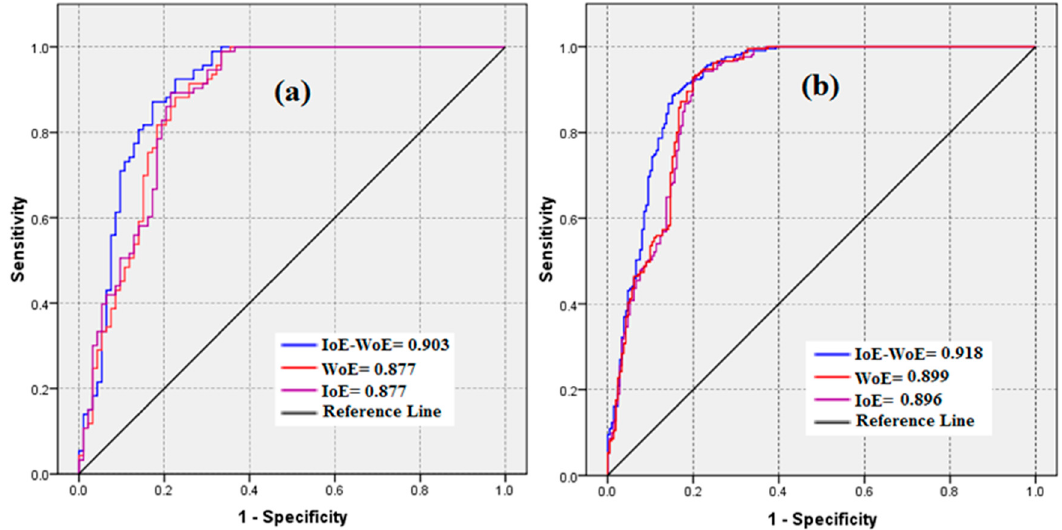
Figure 9. Area under curve values for weight-of-evidence (WoE), index-of-entropy (IoE), and WoE-IoE models: ( a ) validation dataset (prediction rate curve), ( b ) training dataset (success rate curve).